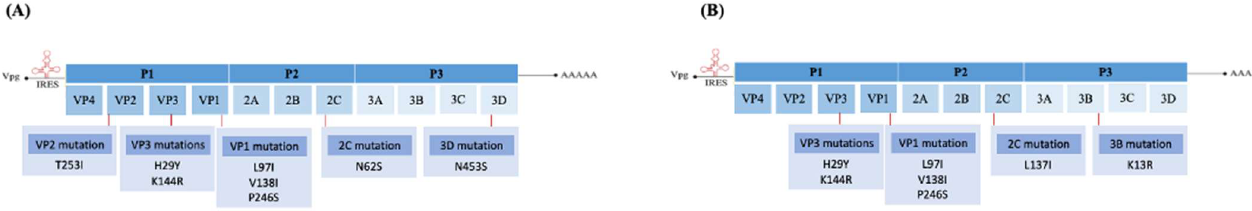
Figure 5. Differences in amino acid sequences between ( A ) EV-A71/VS variant and ( B ) EV-A71/VM variant isolated from Vero cells in comparison with the EV-A71/WT.